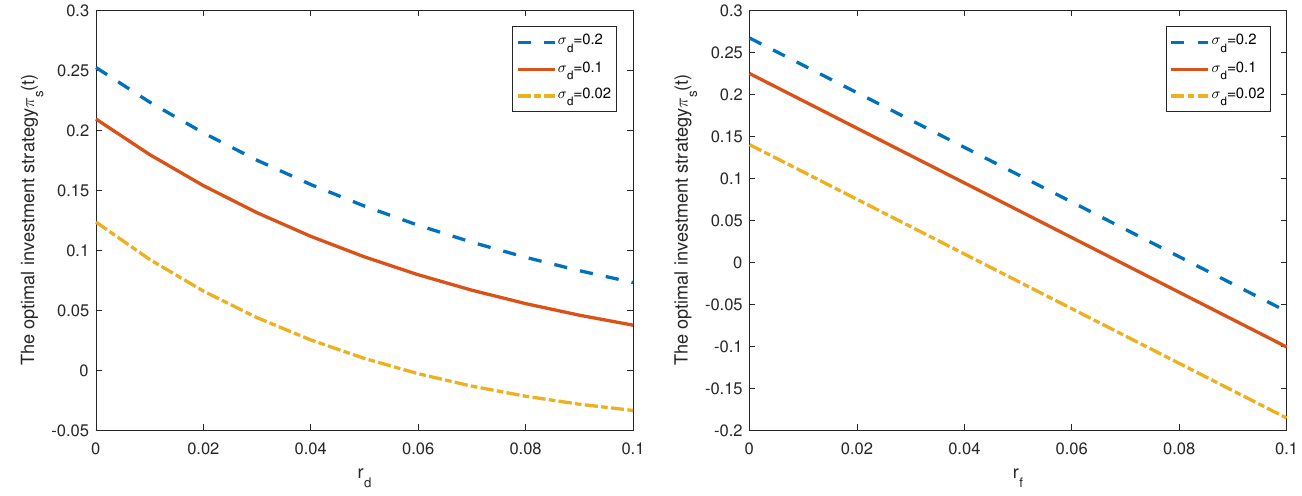
Figure 4. The impact of parameters r d , r f and σ d on π s ( t )